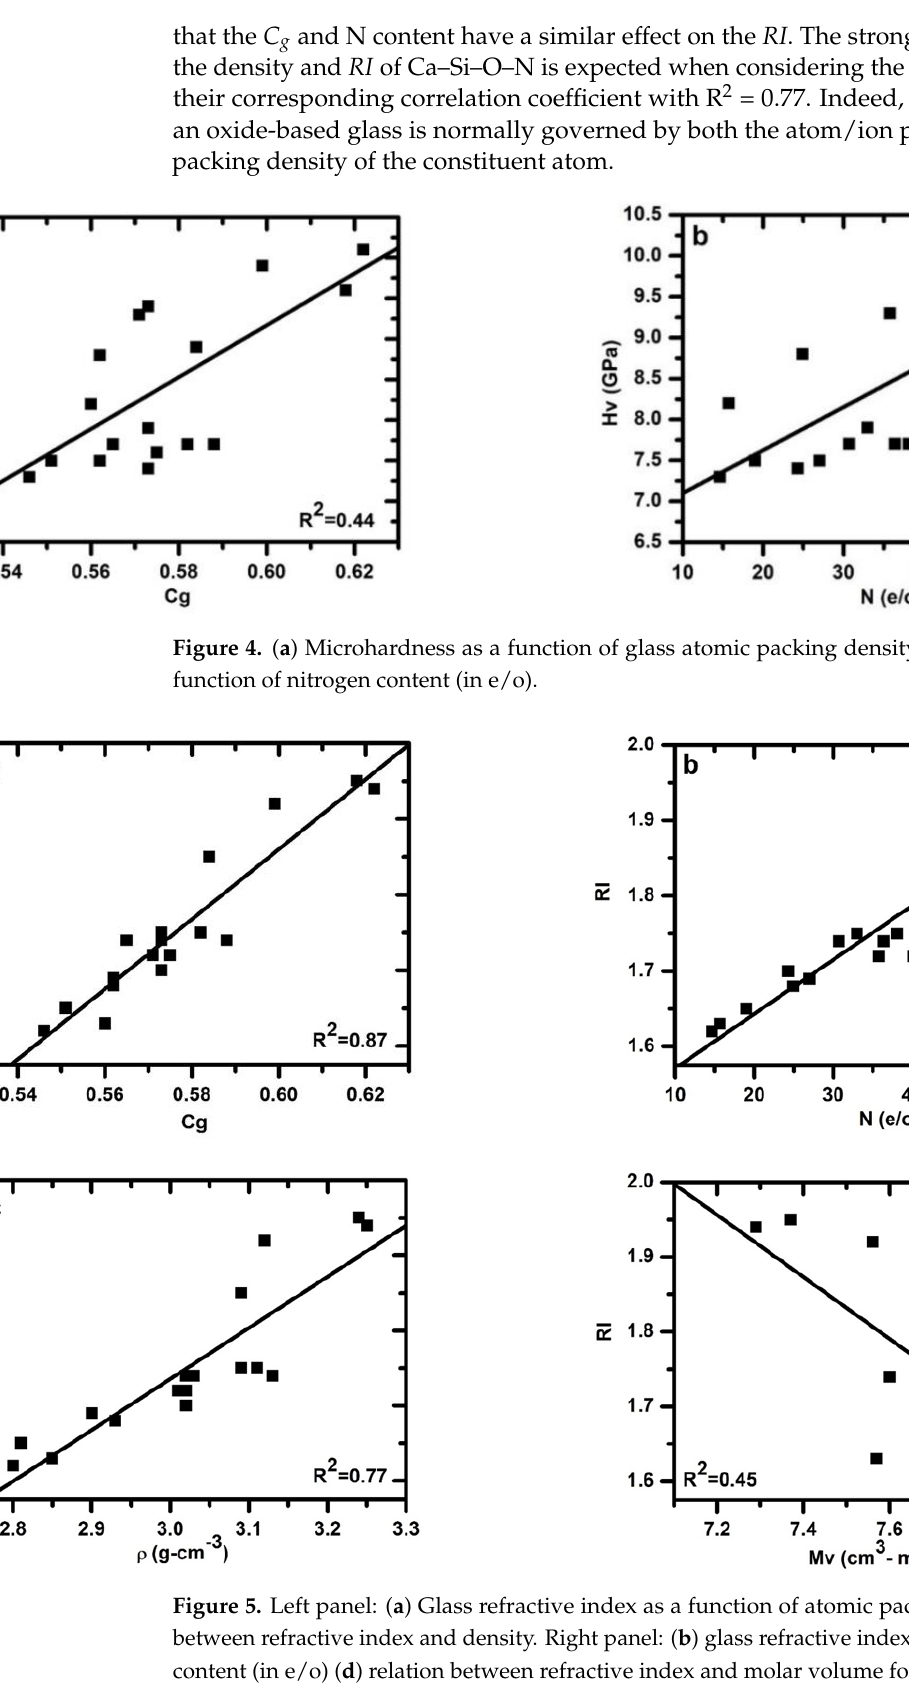
Figure 3. ( a ) Glass transition and crystallization temperatures as a function of glass atomic packing density ( b ) glass transition and crystallization temperatures as a function of nitrogen content.